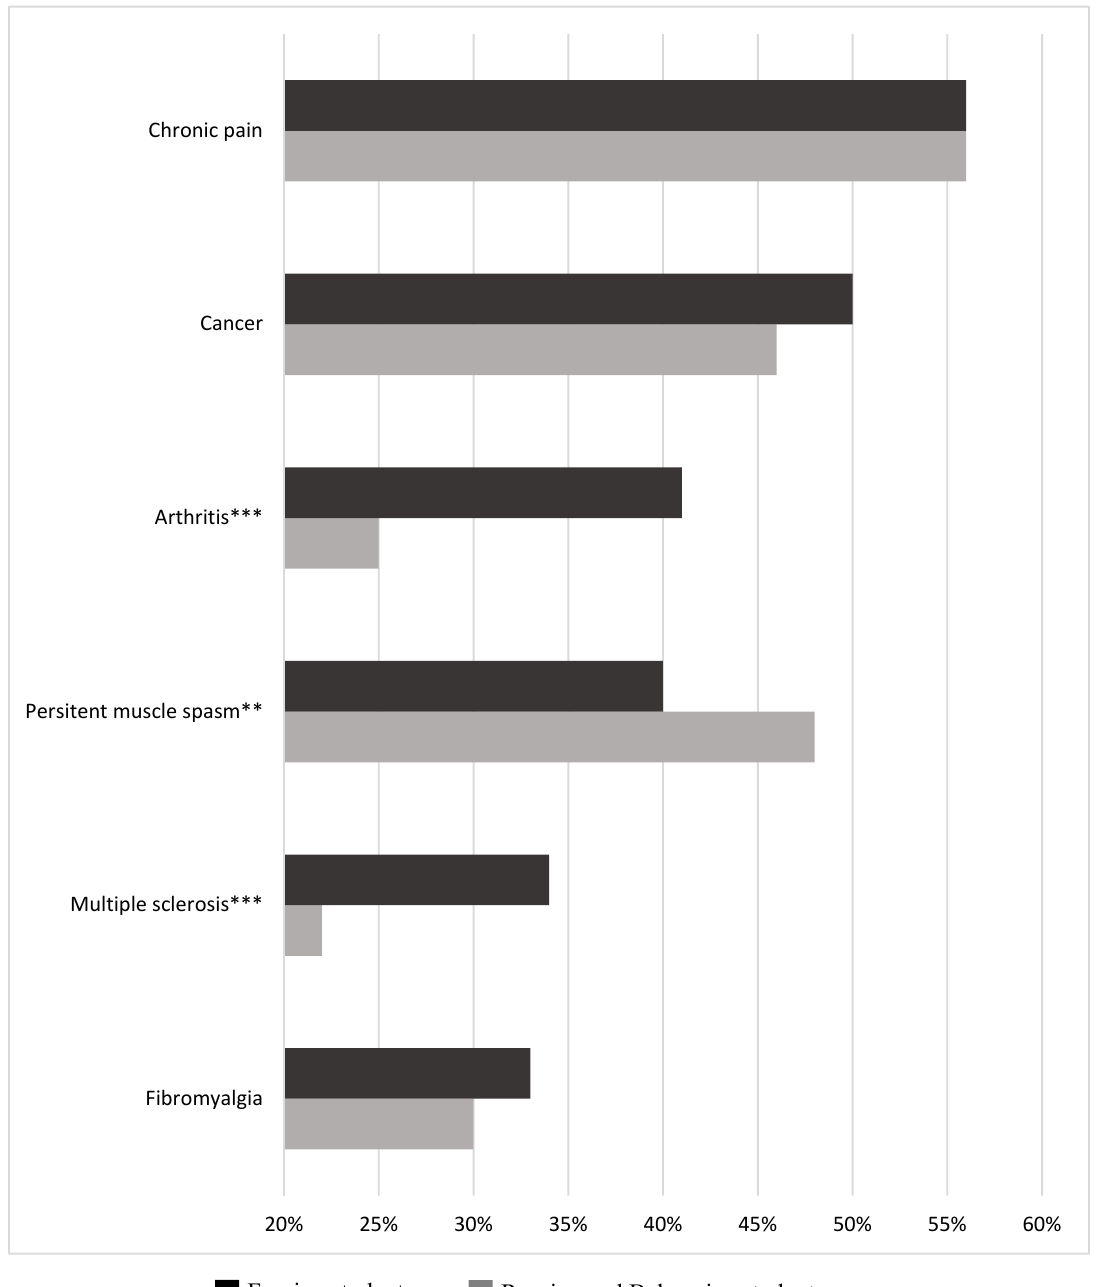
Figure 2. Medical student beliefs about cannabis effectiveness for pain-related conditions, ** p < 0.01; *** p < 0.001 (chi-square test).